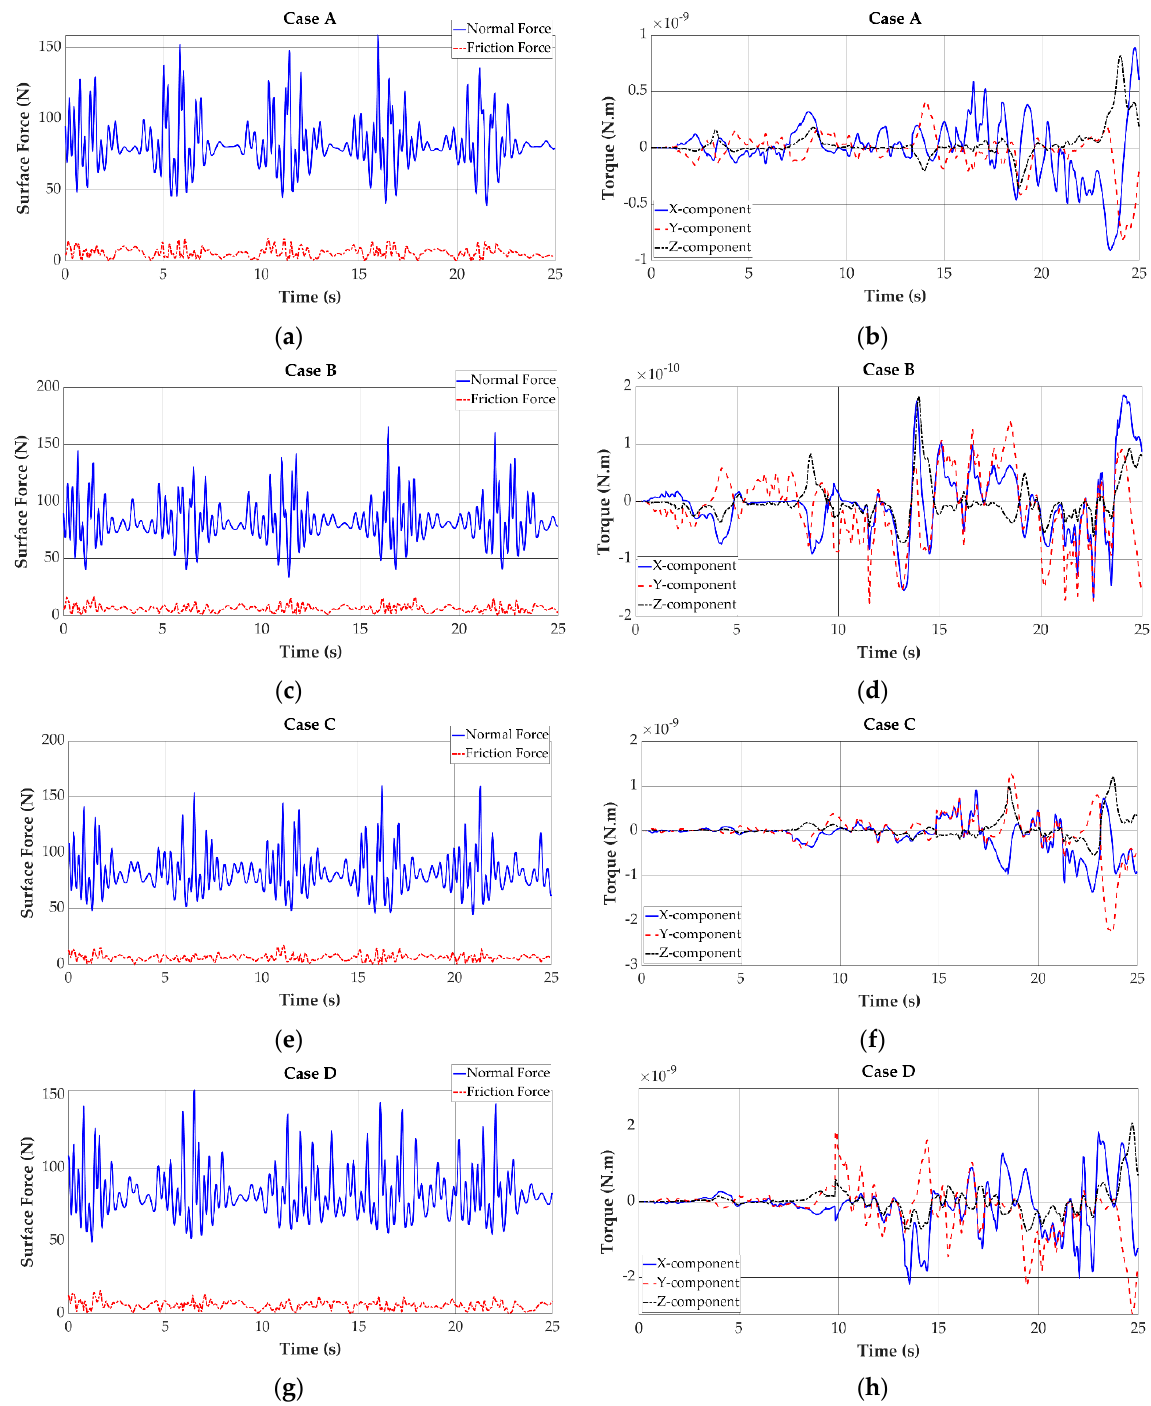
Figure 9. Example 2. Magnitude of normal and frictional forces provided by the surface to the shell at P on the left and the computed torque XYZ at P on the left and the computed torque T P ( g , h ) Case ( g , h ) Case D.